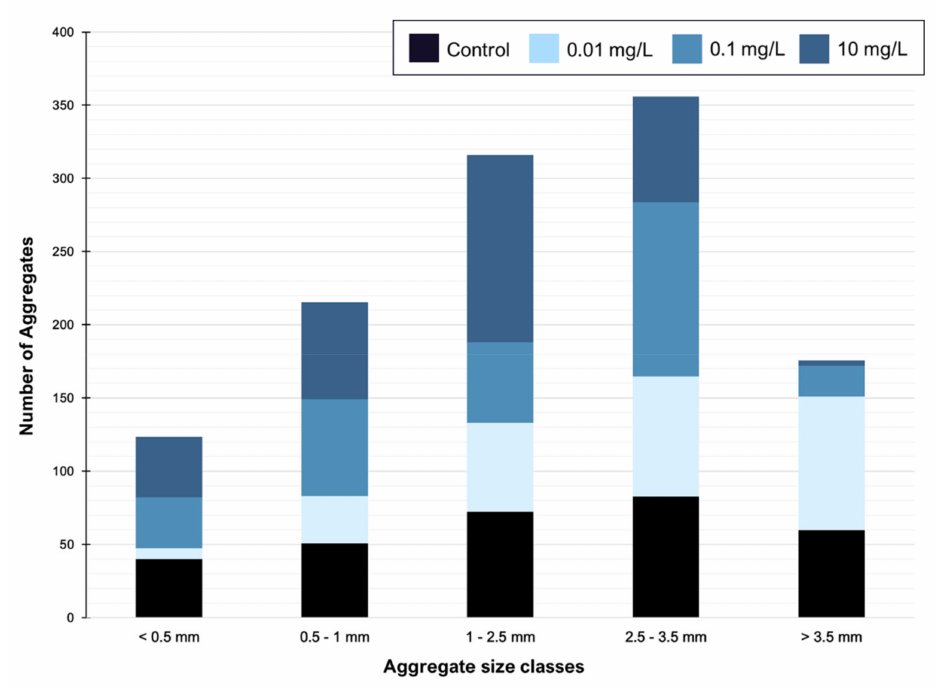
Figure 2. NanoPS exposure leads to a change in aggregation. Aggregates sorted by class size show a significant change in the distribution pattern under nanoPS 42 exposure (Holm-Sidak, p = 0.05). No di ff erences are observed when exposure length is